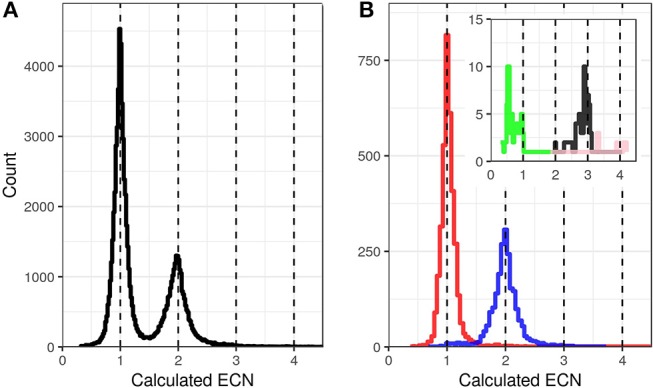
Exon Sequence Copy Number (ECN) calculation based on relative read coverage. Distribution of the calculated ECNs of all exon sequences of 1,000 randomly selected samples (A) and 93 reference samples with known KIR genotypes (B). The ECNs were calculated for all detected exon sequences and plotted as events in histograms with a bin size of 0.02. For (B) the events were separated and color coded based on the known ECNs according to the reference genotypes with ECN = 0 (green, inlay), ECN = 1 (red), ECN = 2 (blue), ECN = 3 (black, inlay), and ECN = 4 (pink, inlay).